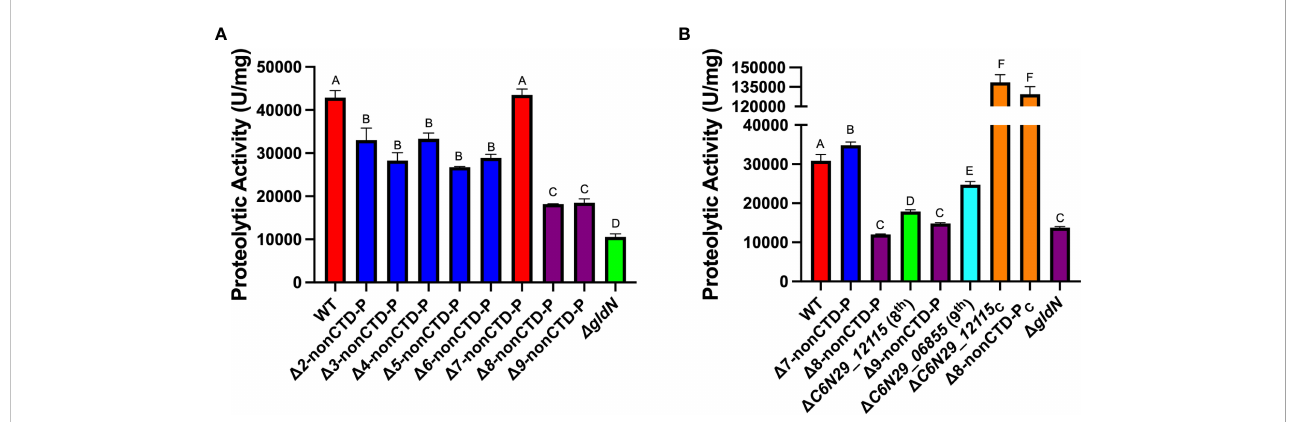
FIGURE 2 Effect of deletion of genes encoding peptidases that lack T9SS CTDs on extracellular proteolytic activities. (A) Strains examined were wild-type F. columnare (WT); FCB54 ( D 2-nonCTD-P); FCB100 ( D 3-nonCTD-P); FCB101 ( D 4-nonCTD-P); FCB102 ( D 5-nonCTD-P); FCB103 ( D 6-nonCTD-P); FCB107 ( D 7-nonCTD-P); FCB117 ( D 8-nonCTD-P); FCB137 ( D 9-nonCTD-P); D gldN . (B) Strains examined were WT; FCB107 ( D 7-nonCTD-P); FCB117 ( D 8-nonCTD- P); FCB147 ( D C6N29_12115); FCB137 ( D 9-nonCTD-P); FCB159 ( D C6N29_06855); D C6N29_12115 complemented with plasmid pHM23 ( D C6N29_12115 C ); D gldN . Statistics correspond to one-way ANOVA with Tukey post-test comparing D 8-nonCTD-P complemented with plasmid pHM23 ( D 8-nonCTD-P C ); all conditions to wild type and each other. Same letter and color: nonsigni fi